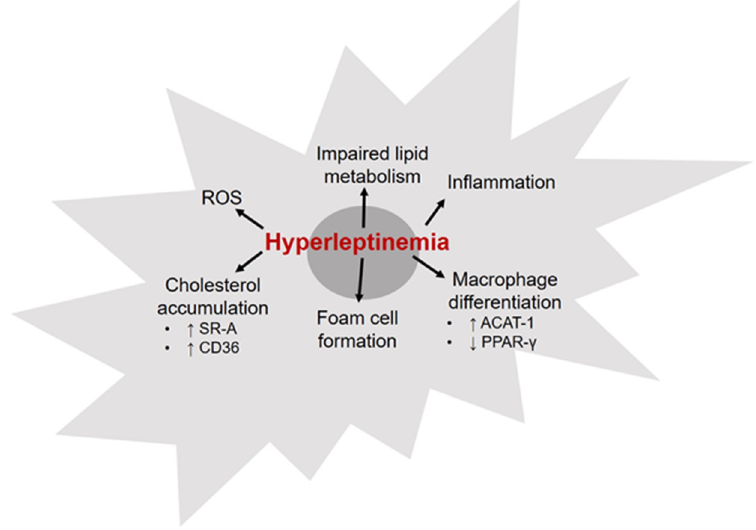
Figure 2. Hyperleptinemia-induced changes on vascular macrophages that contribute to athero- sclerosis. ROS: reactive oxygen species; PPAR- γ : peroxisome proliferator-activated receptor- γ ; SR-A: scavenger receptor-A; ACAT-1: acyl CoA:cholesterol acyltransferase-1. Please see text for addi- tional details.